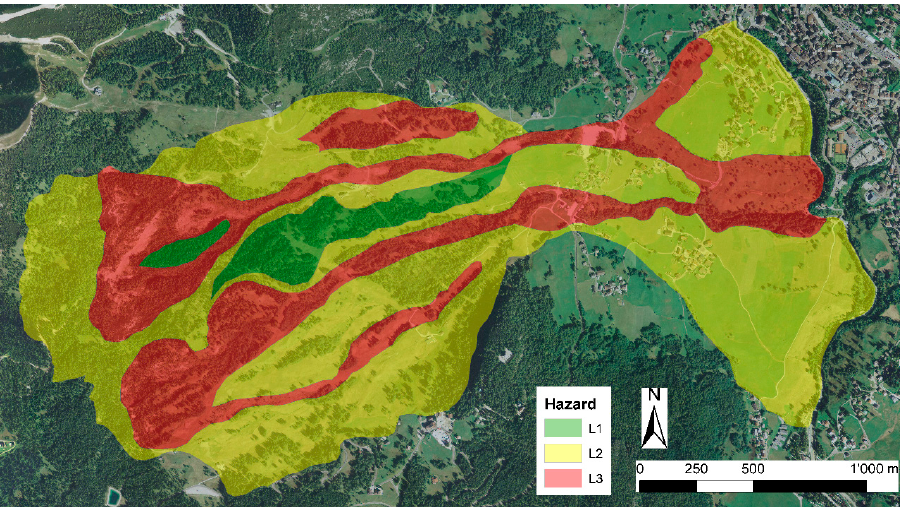
Figure 10. Hazard zonation map for the Mortisa landslide unit.